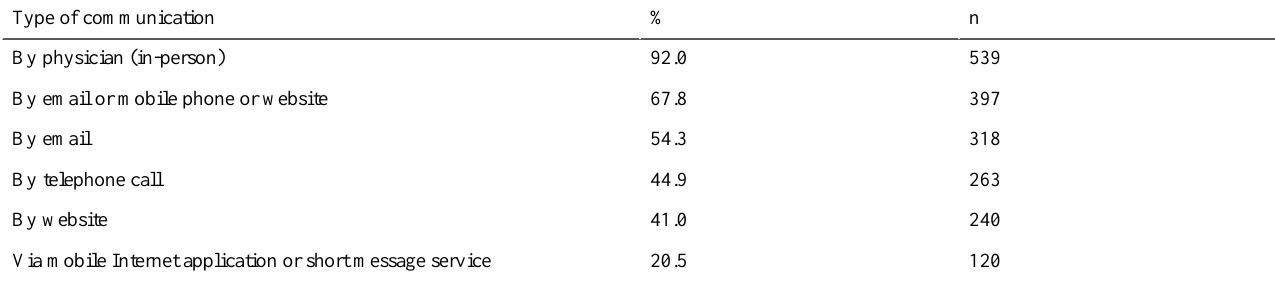
Table 4. Acceptance of modes of communication with health care providers for being informed and instructed during multiple sclerosis therapy (MS) by patients with MS (n =